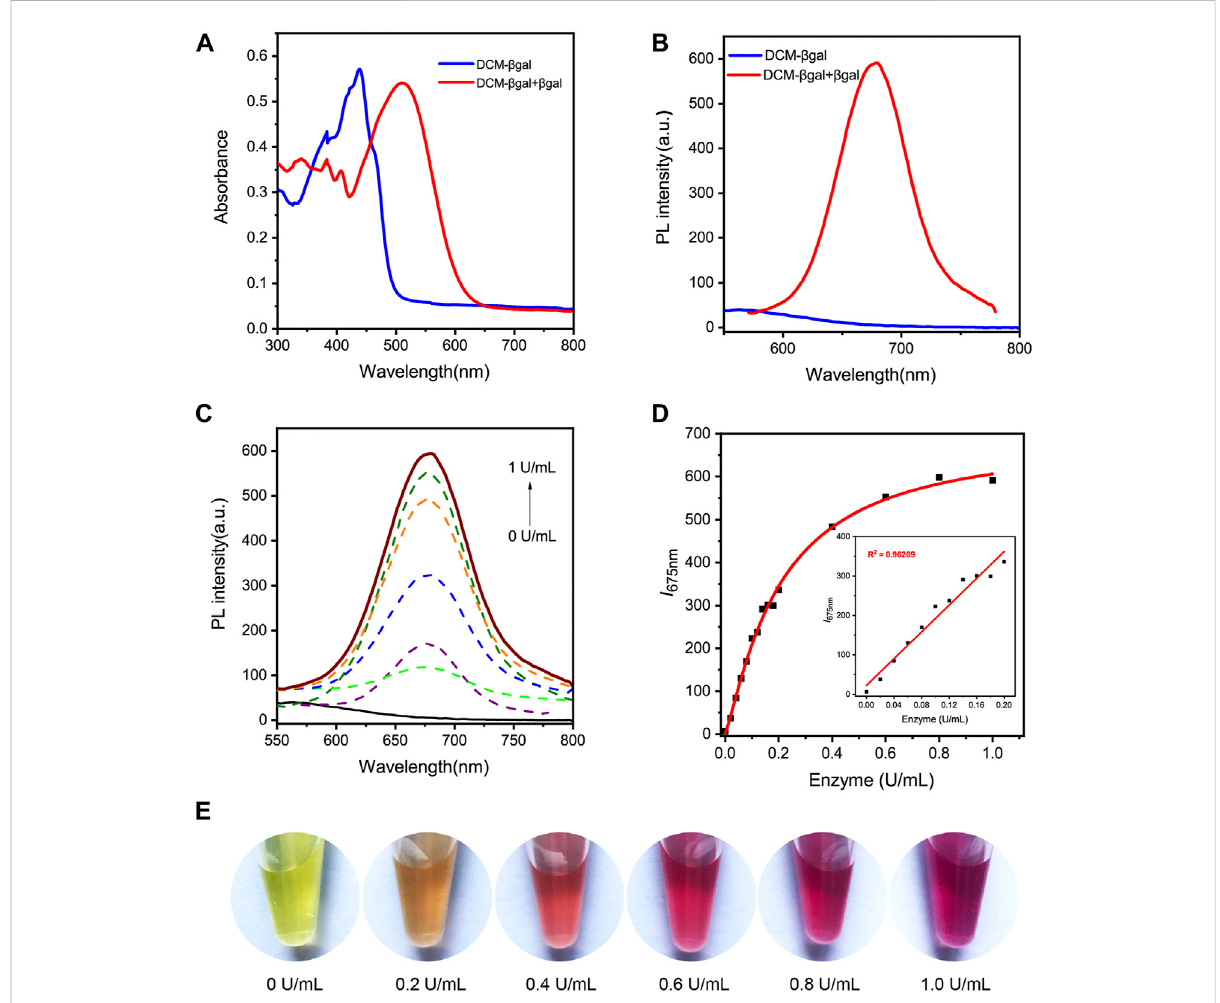
FIGURE 2 Spectral properties of DCM- β gal. (A) Normalized UV-vis absorption of DCM- β gal (100 μ M) and DCM- β gal (100 μ M) incubation with β -gal (1 U ml − 1 ) in aqueous solution (PBS/DMSO = 7:3, v:v, pH = 7.4, 37 ° C). (B) Photoluminescence (PL) spectra of DCM- β gal (100 μ M) and DCM- β gal (100 μ M)incubation with β -gal(1U ml − 1 )inaqueoussolution(PBS/DMSO = 7:3,v:v, pH=7.4, 37 ° C). (C) Emissionspectra of DCM- β gal upon addition ofdifferentconcentrations β -gal(0 – 1U ml − 1 ), λ ex=535 nm. (D) ThepeakintensityofDCM- β galat675 nmtowardvariousconcentrationsof β - gal (0 – 1 U ml − 1 ). Inset: the linear relationship between I 675 nm and β -gal concentration in a range from 0 U ml − 1 to 0.2 U ml − 1 (E) The photographs of DCM- β gal upon addition of various concentrations of β